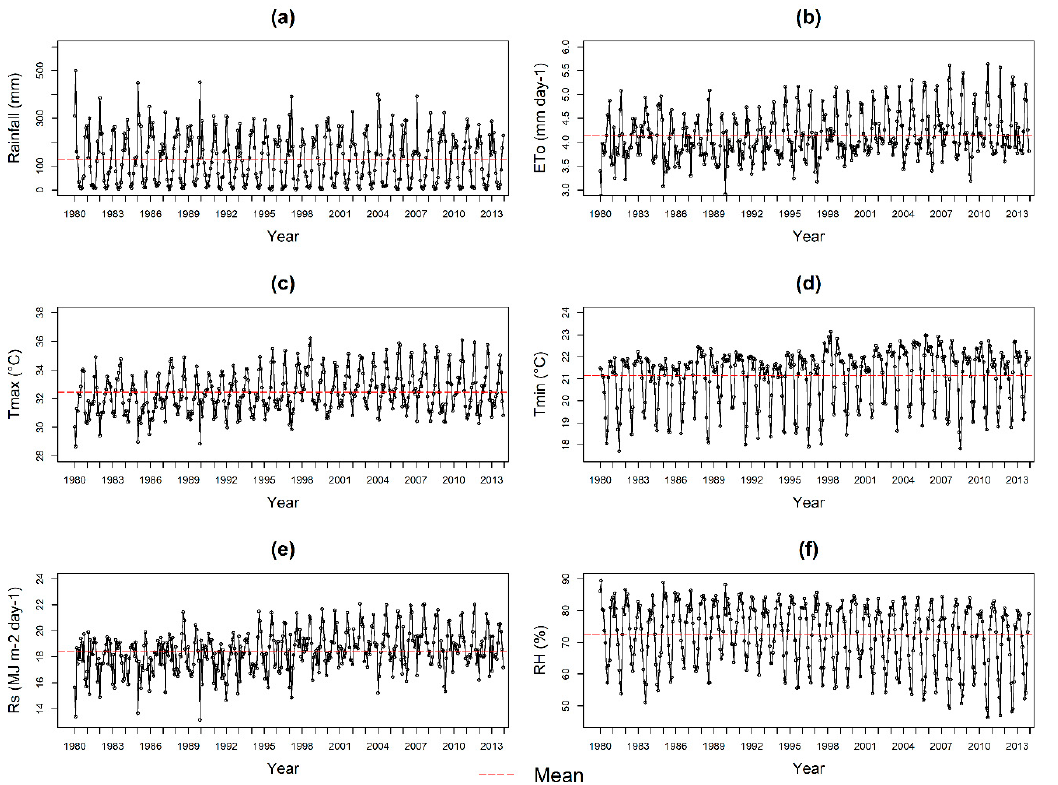
Figure 3. Monthly frequency distribution of the meteorological variables in the period from 1980 to 2013 in the MATOPIBA region. ( a ) Rainfall, ( b ) ETo: Reference Evapotranspiration, ( c ) Tmax: Maximum Temperature, ( d ) Tmin: Minimum Temperature, ( e ) Rs: Solar Radiation and ( f ) RH: Relative Humidity. Table 5. Summary of the results of the non-parametric Mann–Kendall test (Z-test) in the annual series of meteorological variables in the period from 1980 to 2013 in the MATOPIBA region.